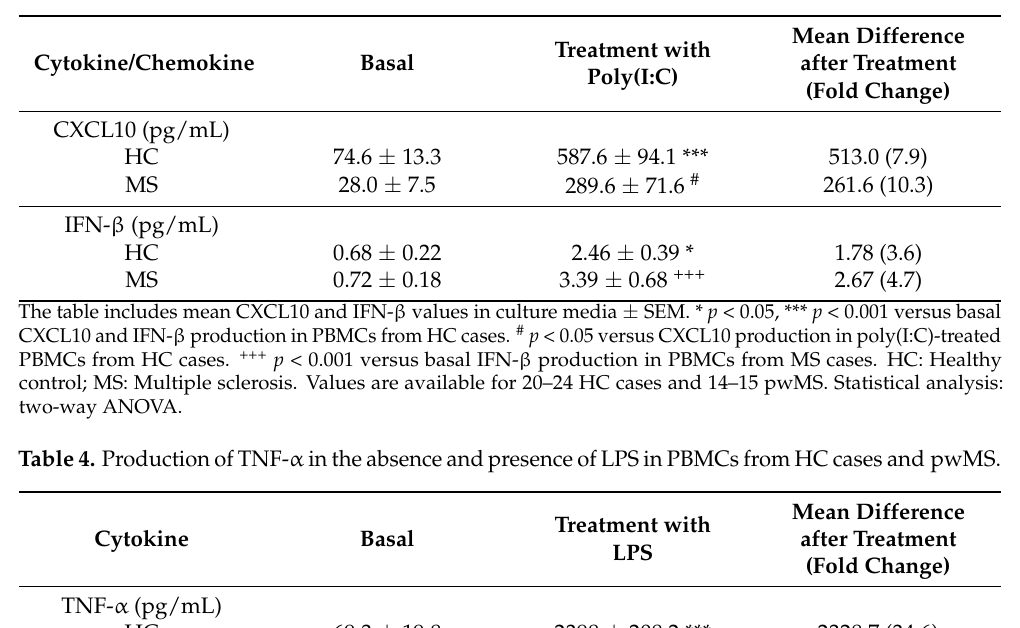
Table 3. Production of CXCL10 and IFN- β in the absence and presence of poly(I:C) in PBMCs from HC cases and pwMS.